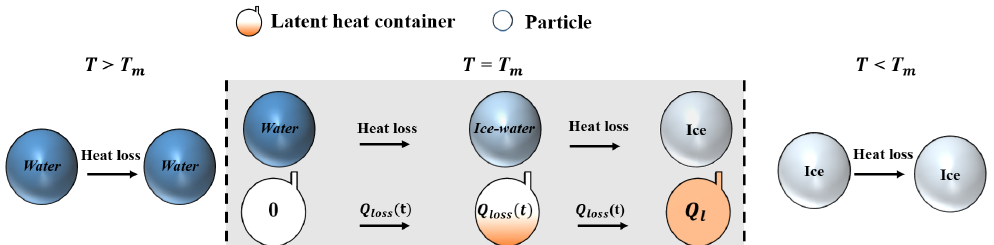
Figure 5. Latent heat storage model used in the SPH